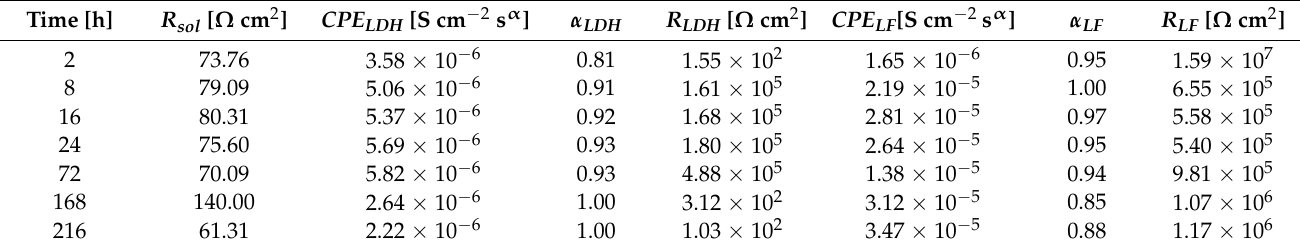
Table 4. Results of EIS fitting for C10-9 sample.